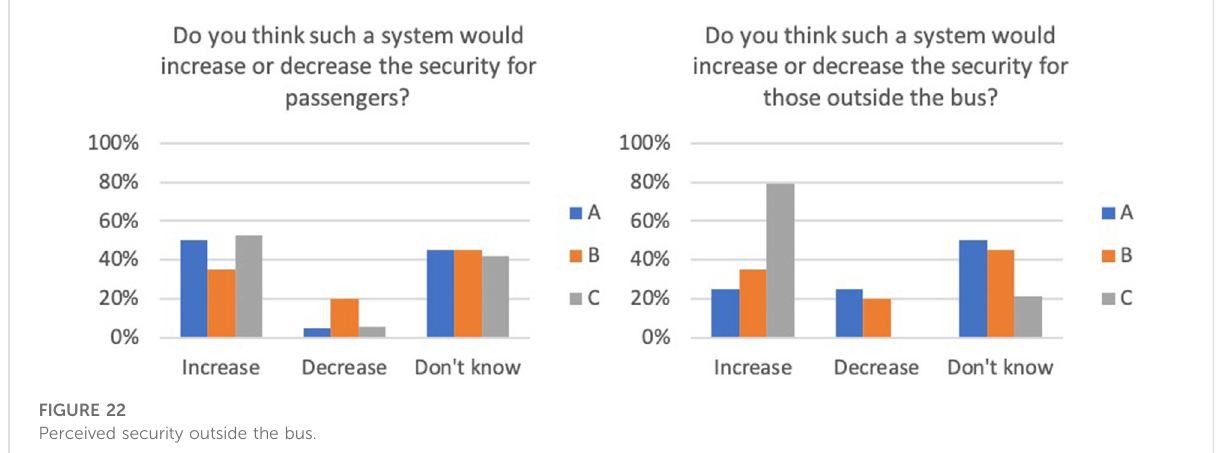
FIGURE 22 Perceived security outside the